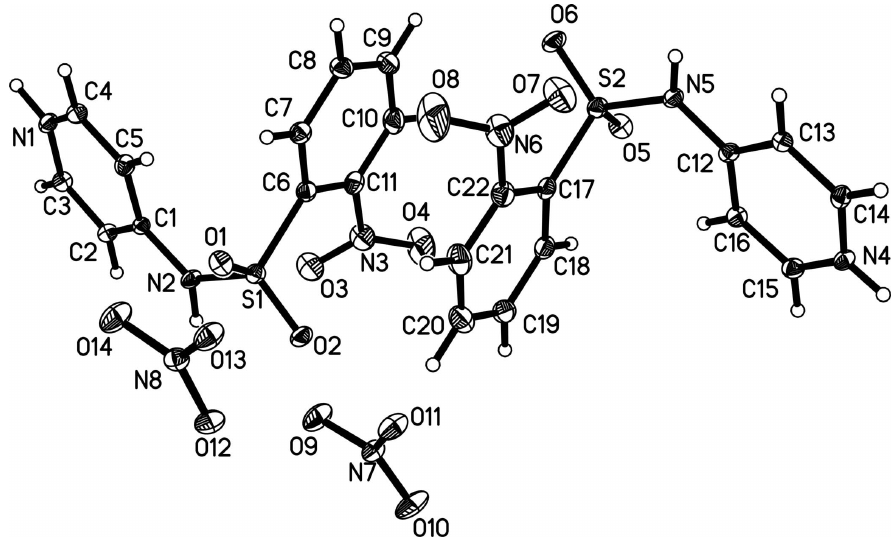
The molecular structure of the title compound, showing the two symmetry-independent molecules with the atom numbering scheme. Displacement ellipsoids are drawn at the 35% probability level. H atoms are presented as a small spheres of arbitrary